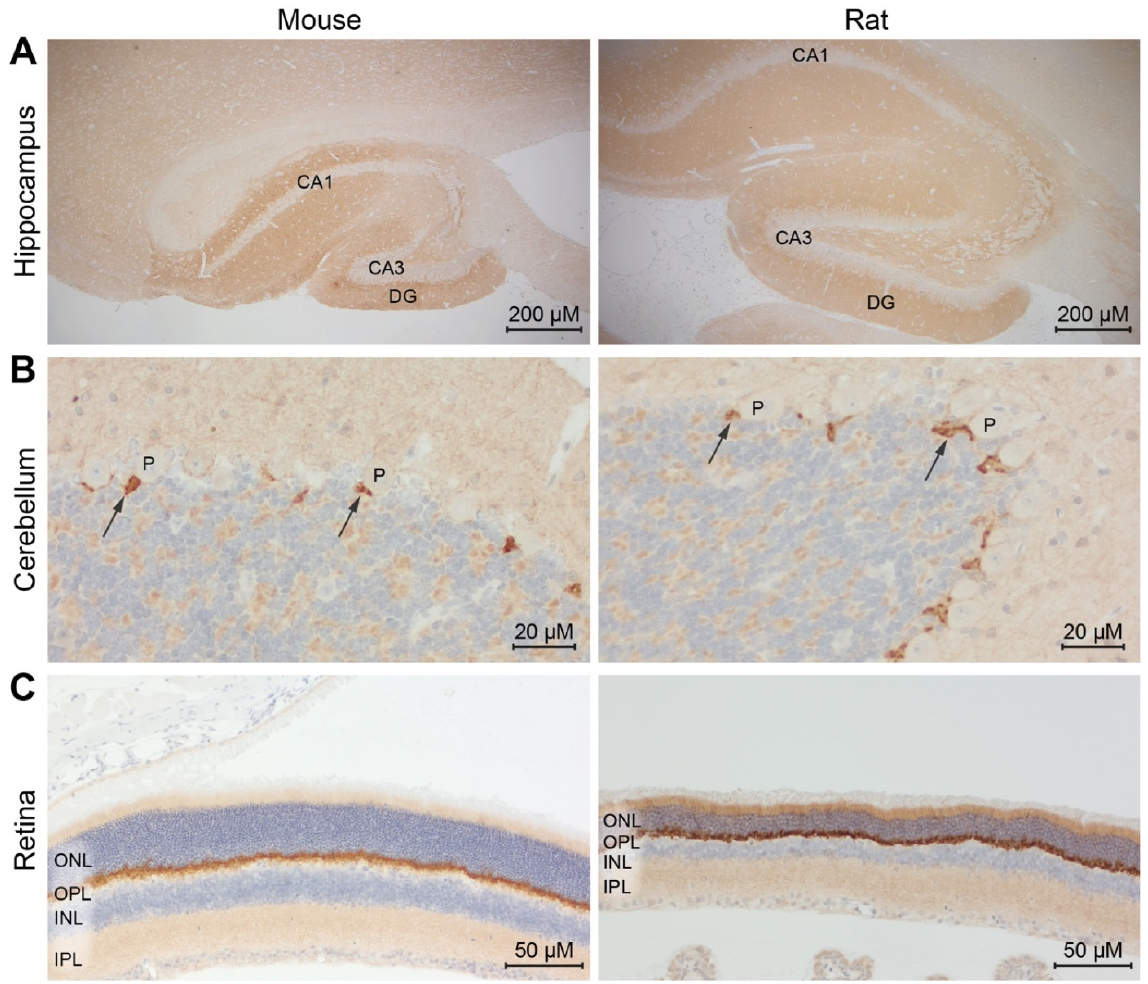
Figure 7. IHC-P using an anti-PSD95 r-hcAb. Chromogenic IHC staining of an anti-PSD95 r-hcAb in formalin-fixed paraffin-embedded (FFPE) mouse (left) and rat (right) tissue sections using 3,3 ′ - Diaminobenzidin ( DAB; brown staining ). Hematoxylin provides blue nuclear staining. ( A ) Immunohistochemistry using the rabbit anti-PSD95 r-hcAb reveals the characteristic distribution of PSD95 in coronal sections of mouse and rat hippocampi. All regions of the hippocampus are labeled. However, DAB staining is more intense in the pyramidal cell layer of the CA1 area and in the molecular layer of the dentate gyrus (DG). ( B ) High-magnification views of mouse and rat FFPE cerebellum sections. Strong PSD95 staining is detected within the basket cell terminal pinceaux (arrows). Purkinje cells (P) and neurons in the granule layer are not stained. ( C ) In FFPE sections of mouse and rat retina, very intense DAB staining is present in the outer plexiform layer (OPL). Moderate punctate staining is observed in the inner plexiform layer (IPL). The inner and outer nuclear layers (INL and ONL) are not stained.